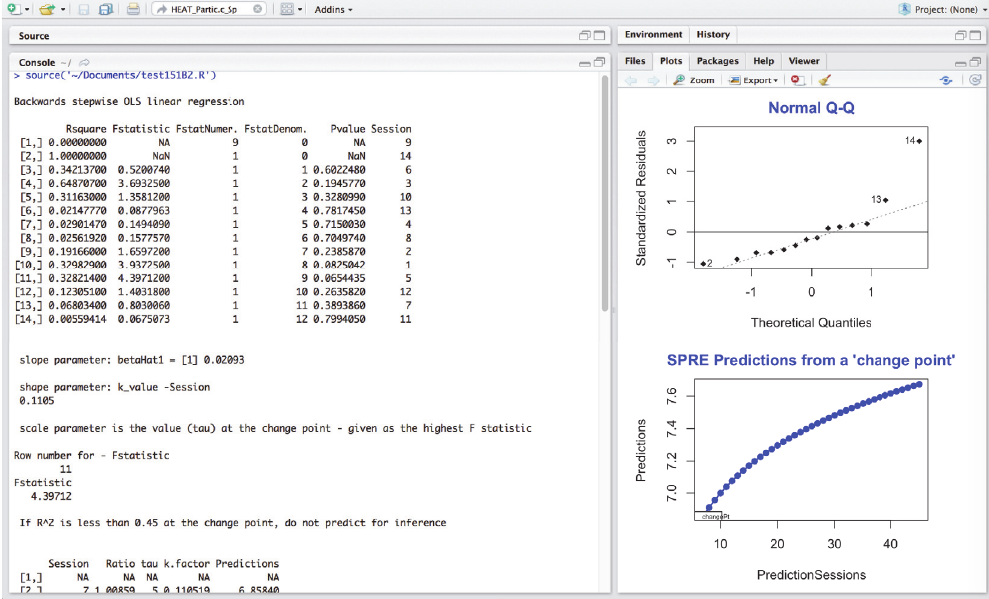
Figure 4: HEAT standardized residuals analysis for Partic.c sensory processing in